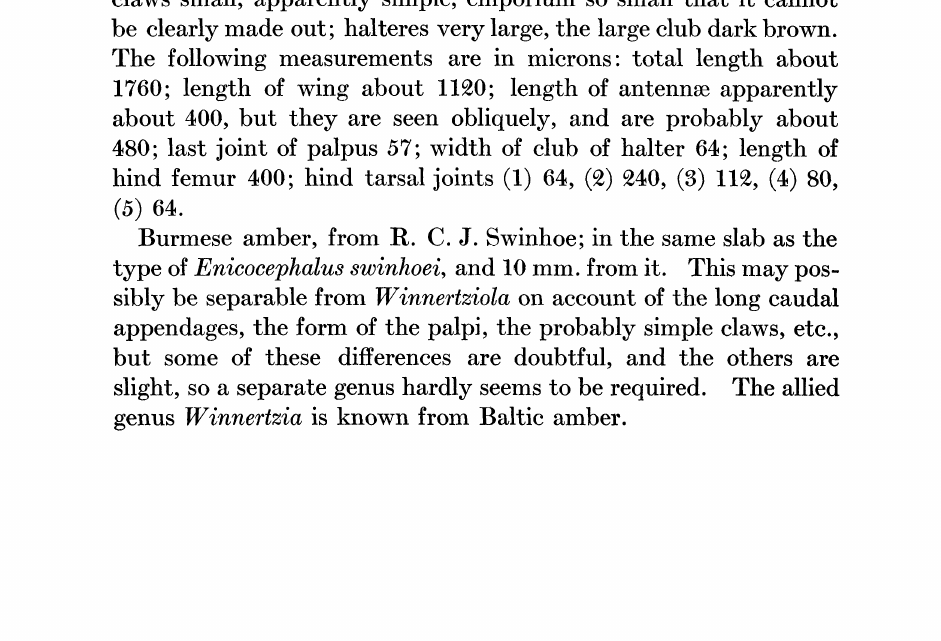
Fig. 3. Winnertziola burmitica. A, wing; B, halter; C, claws; D, palpus; E, basal part of an- tenna; F, end of antenna; G, caudal appendages.